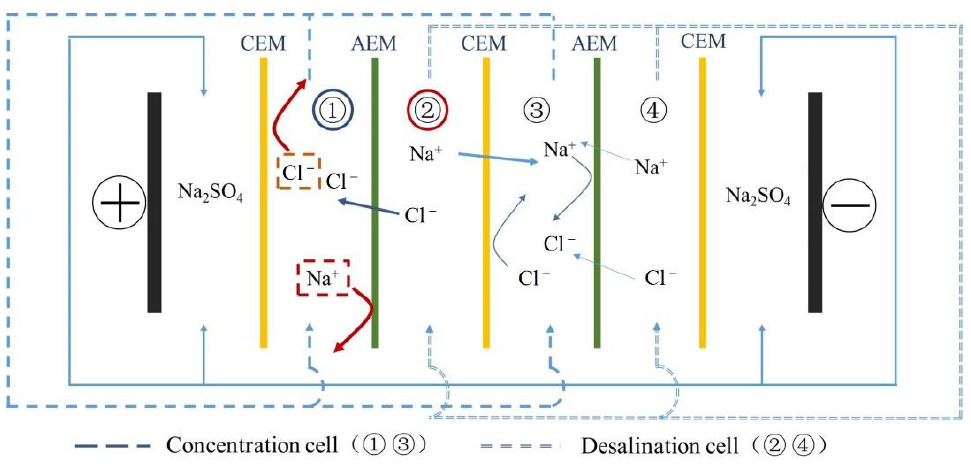
Figure 3. The schematic principle of ED